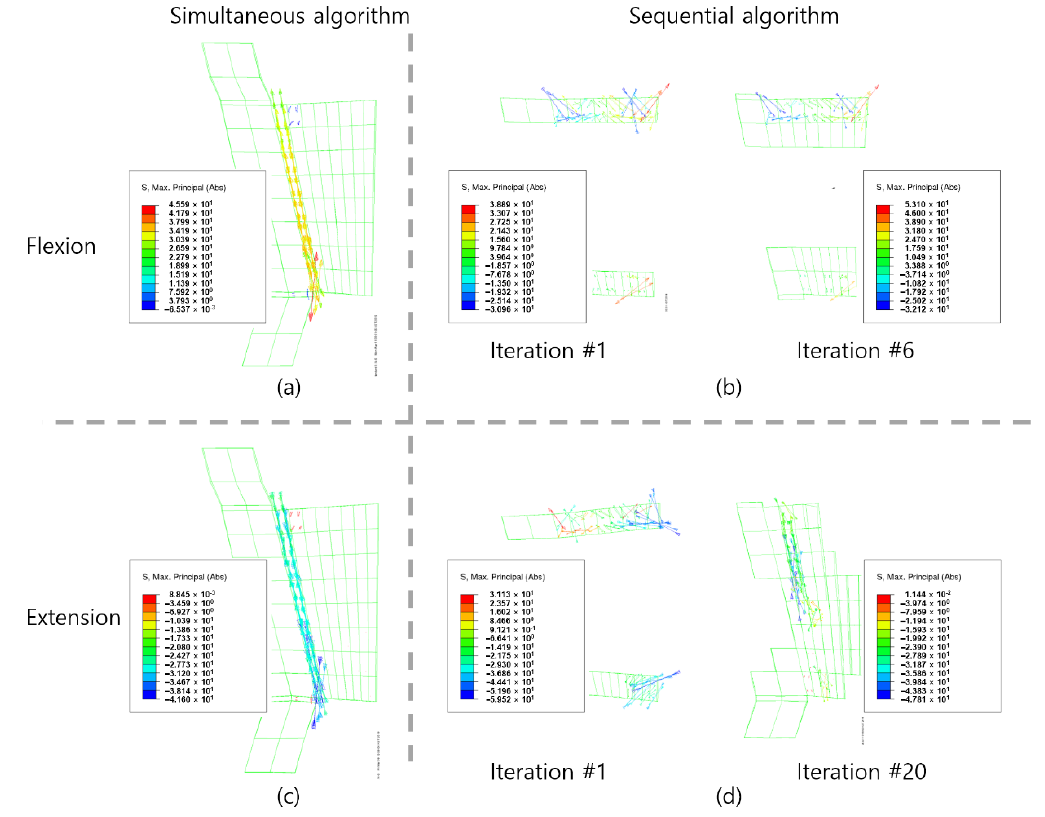
Figure 10. Directions of the maximum principal stress in the predefined potential region of the extragraft bone formation region during ( a , b ) flexion ( c , d ) and extension.